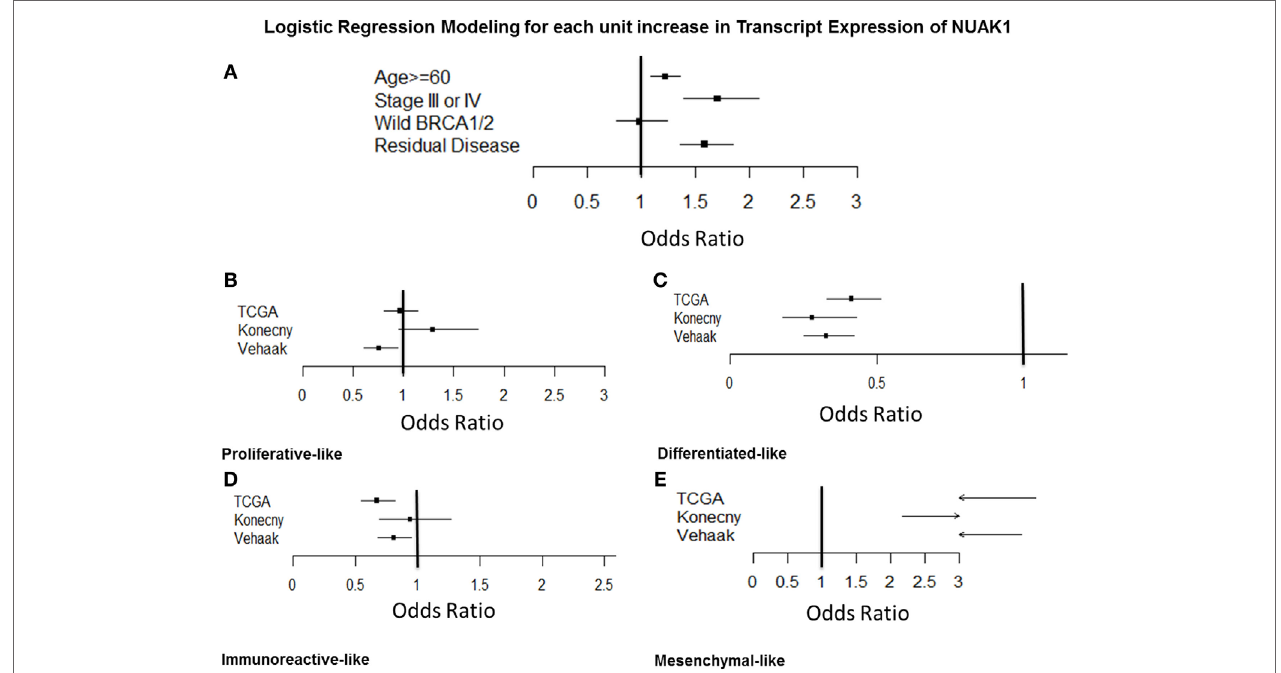
FigUre 3 | Odds ratios analyses of nUaK1 transcript expression relative to relevant clinicopathological criteria and molecular disease subtypes of high-grade serous ovarian cancer . Forest plots detailing odds ratio of patients exhibiting elevated NUAK1 transcript expression relative to clinic-pathological criteria and molecular disease subtypes in public gene expression data. Raw odds ratios results and patient cohorts available for analyses detailed in Table S3 in Supplementary